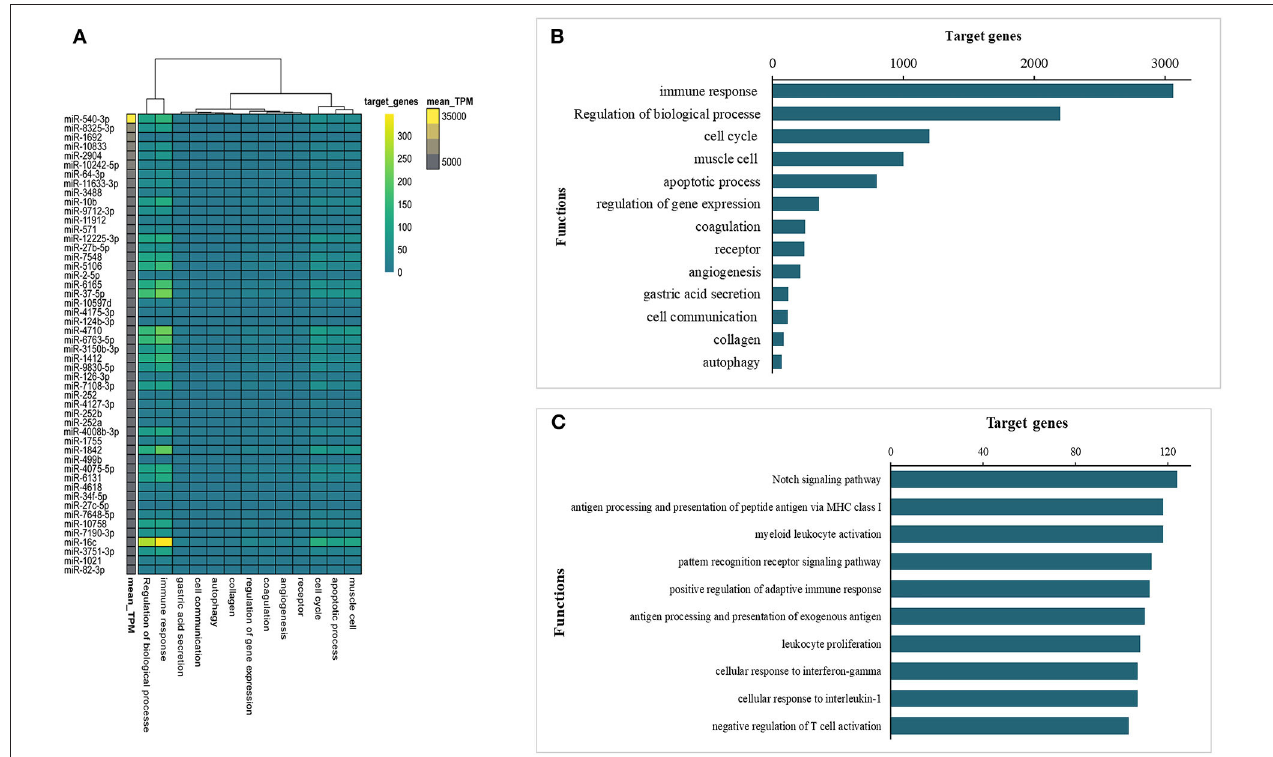
Table S1 . (B) Total number of targeted gene networks identified and classified based on different biological process. Data are available in Table S1 . (C) Total number of targeted gene networks identified and classified as “immune response.” Data are available in Table S1